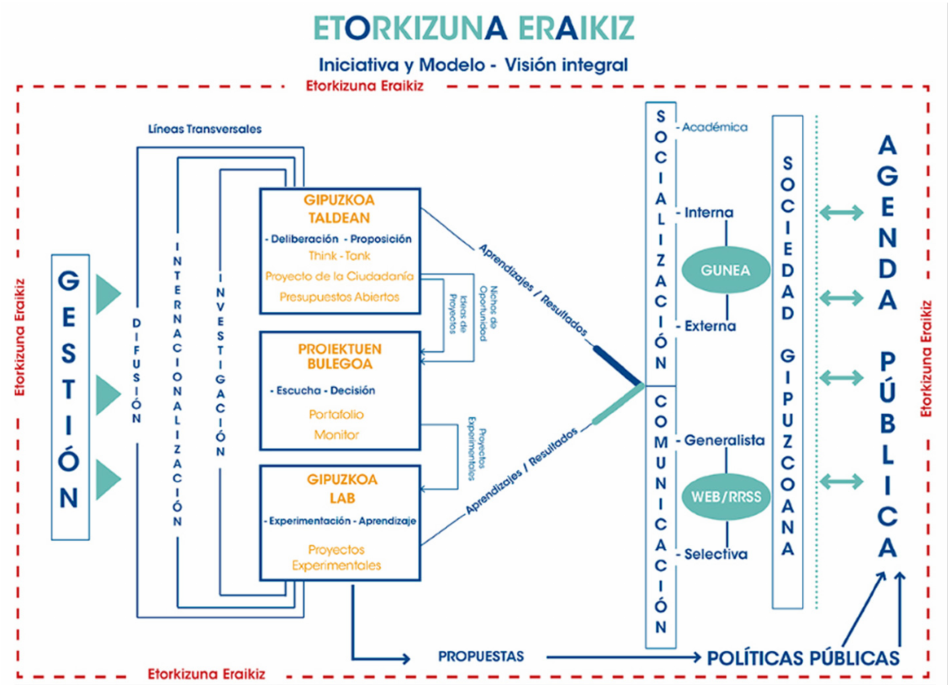
Figure 2. Source: official site of Etorkizuna